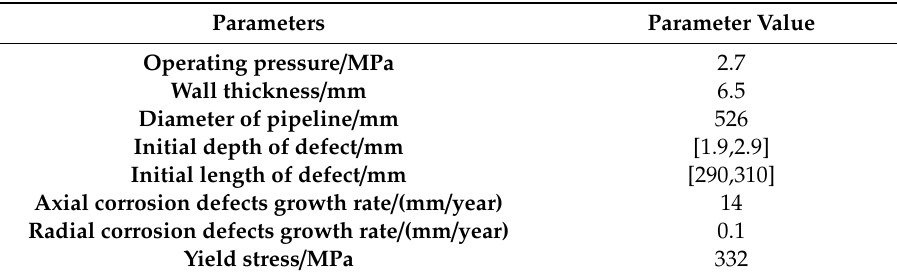
Table 1. Basic parameters of corroded